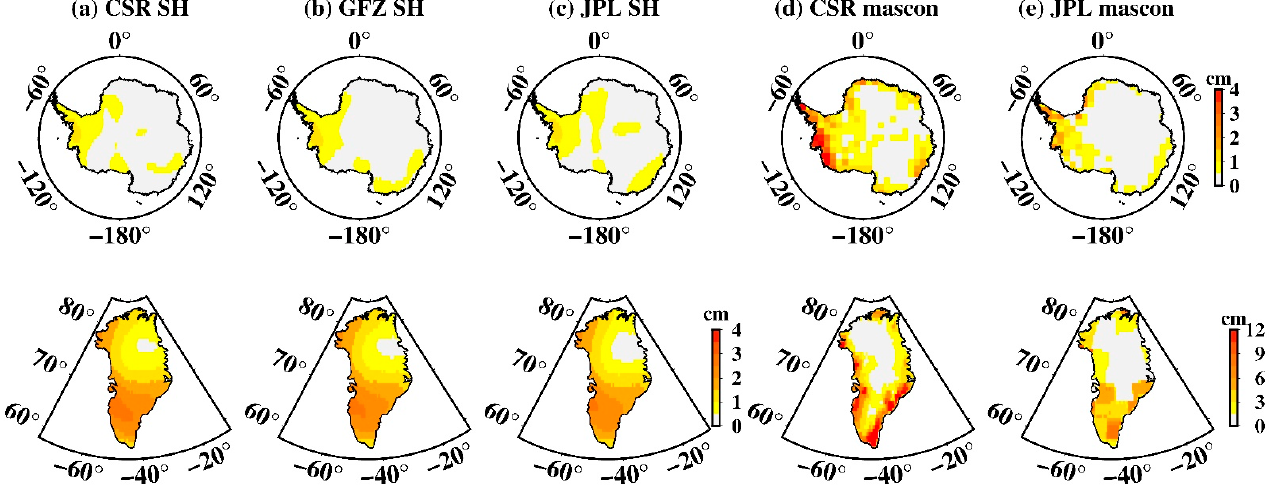
Figure 13. Spatial amplitude maps of semi-annual oscillation over Antarctica and Greenland. ( a – e ) Estimated from CSR SH data, GFZ SH data, JPL SH data, CSR mascon data, and JPL mascon data, respectively.